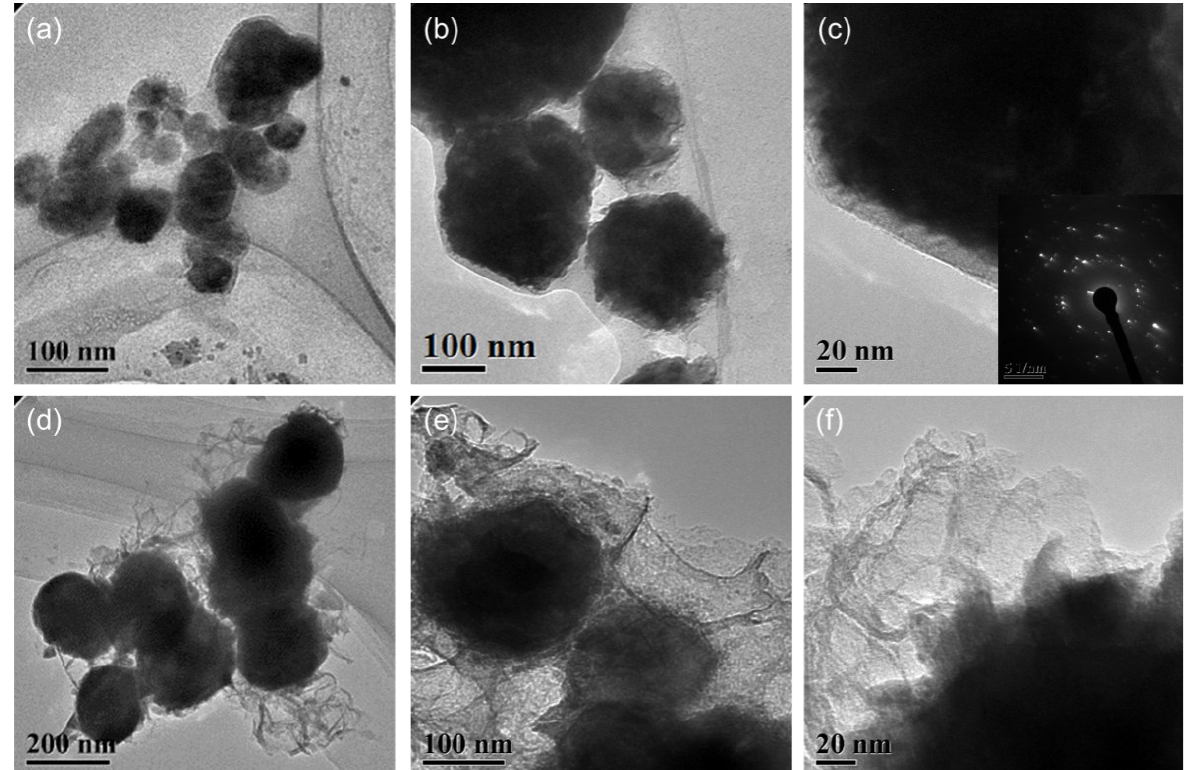
Figure 5. TEM images of the ( a – c ) Cu@organic and ( d – f ) Cu@MC.